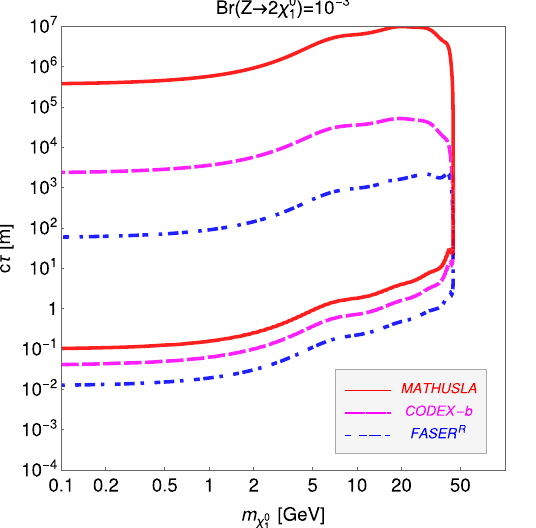
Fig. 16 Projected sensitivity of CODEX-b for light neutralinos with R-parity violating coupling, as produced in Z decays, reproduced from Ref. [83] with permission of the authors. Also shown are projections